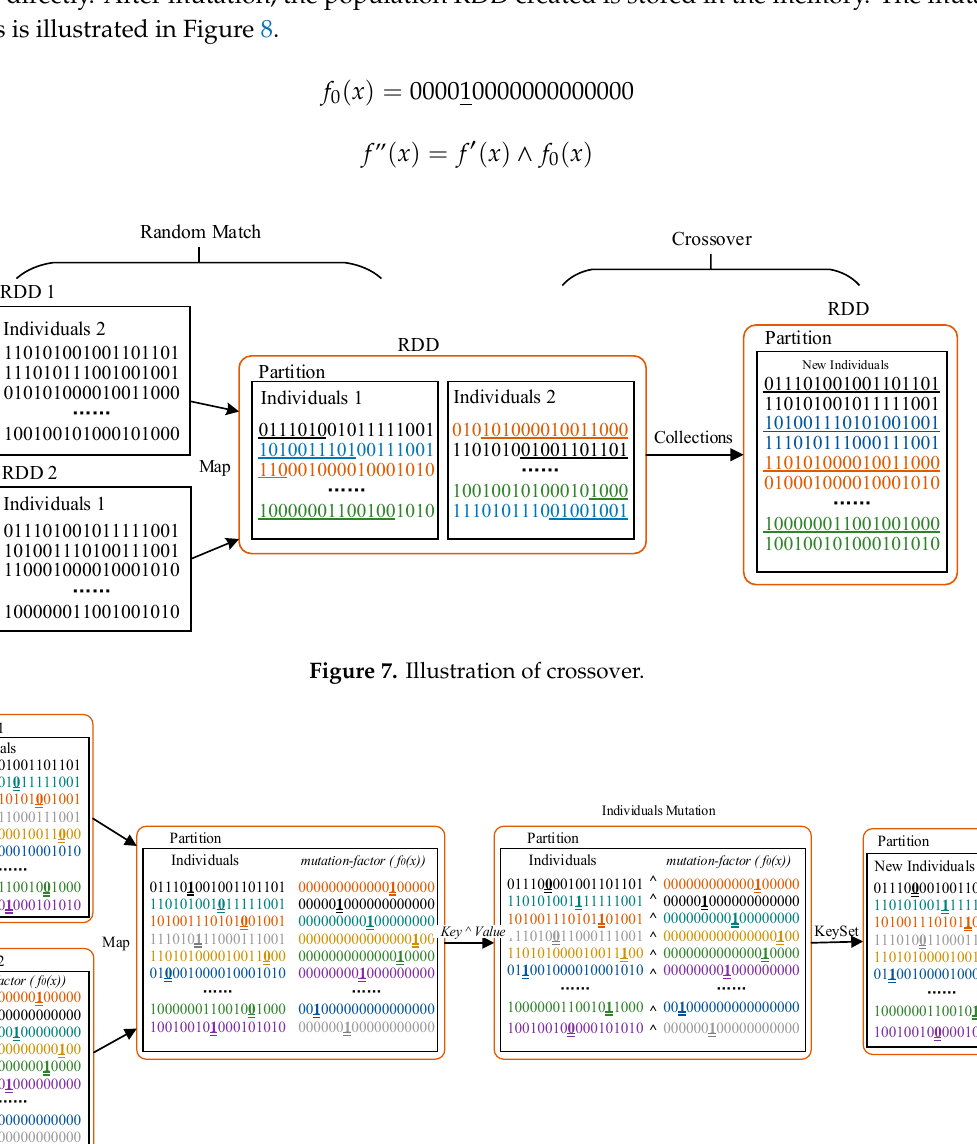
Figure 8. Illustration of mutation.